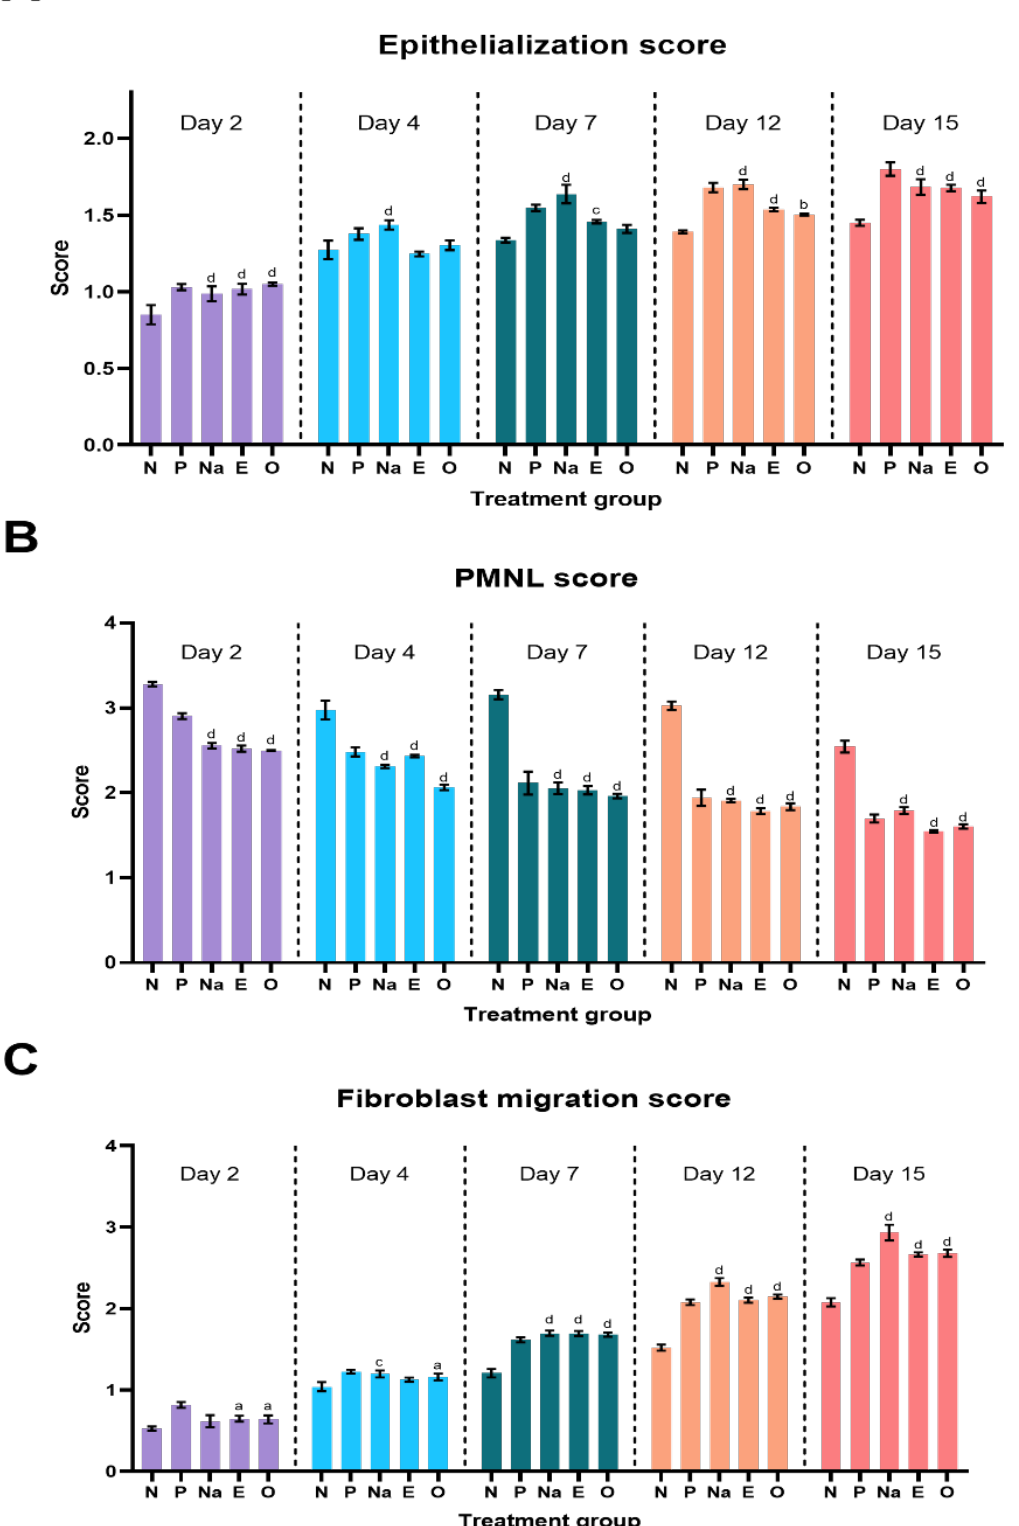
Figure 8. Semi-quantitative parameter analysis of ( A ) epithelialization score ( B ) PMNL score and ( C ) fibroblast migration score. Letters ‘a’ represents p < 0.05, ‘b’ for p < 0.01, ‘c’ for p < 0.001 and ‘d’ for p < 0.0001 against the negative group of their respective days.